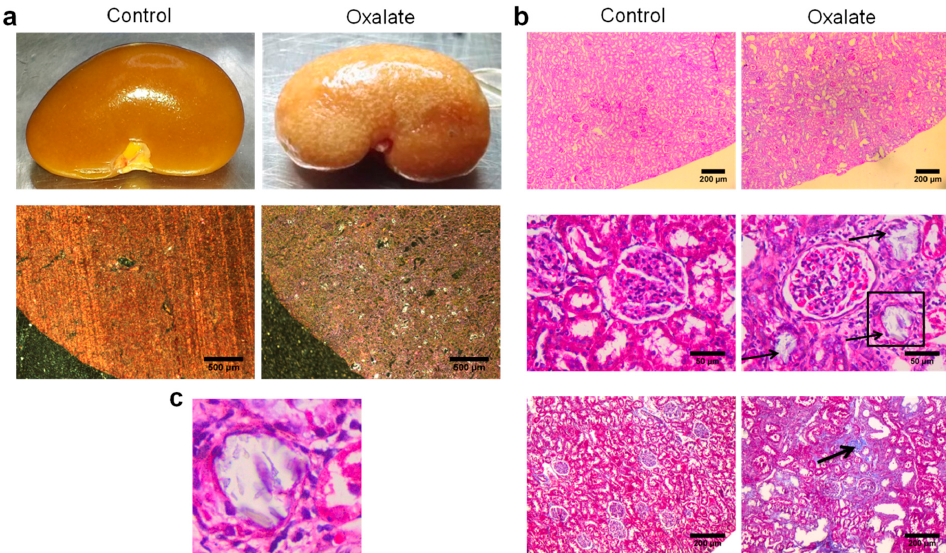
Figure 3. Representative morphological analyses of the kidneys of rats treated with OXA diet compared to controls: ( a ) morphology of the right kidney after its retrieval (upper line) and observation of kidney section under polarized light showing presence of crystals within the cortex; ( b ) periodic acid shift staining of sliced kidney showing massive cortical disorganization (upper line), presence of several atrophied tubules (middle line) and areas of fibrosis (lower line); ( c ) enlargement of the atrophied tubule highlighted with a black square in subfigure b showing the presence of crystals within the tubular lumen.